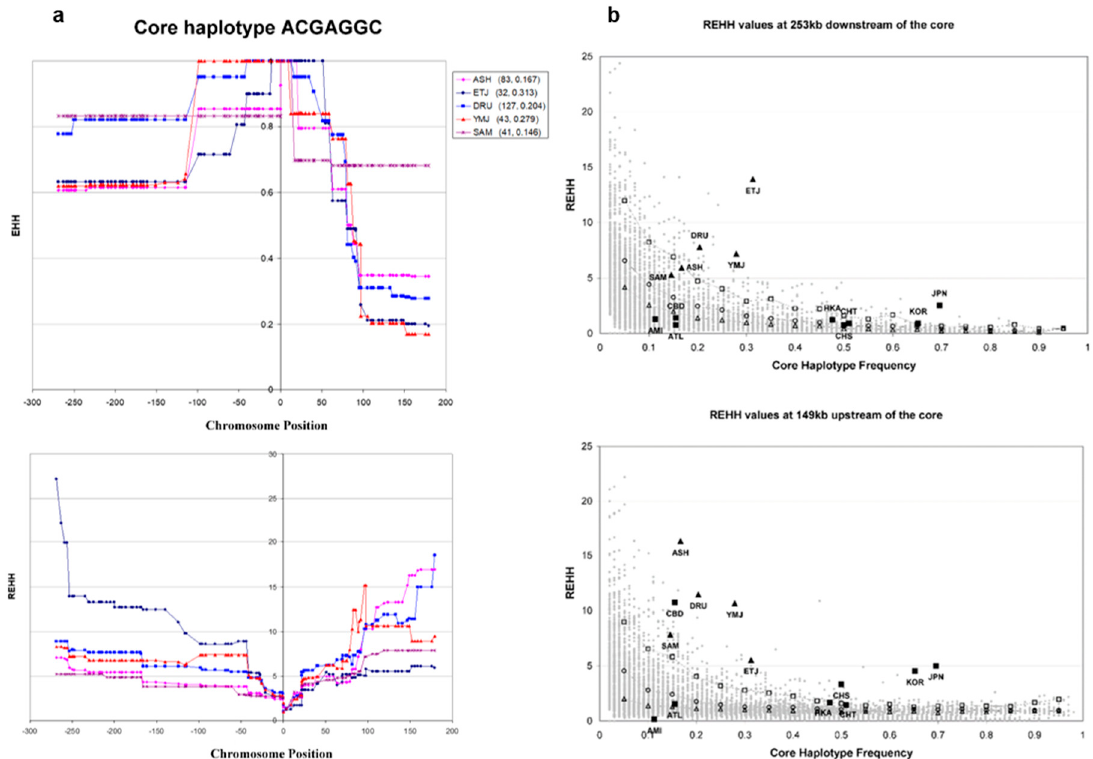
Figure 5. Extended haplotype homozygosity (EHH) and Relative EHH (REHH) plots in Southwest Asian and East Asian populations. The core haplotype position is defined to be zero. The left side of the core is toward downstream direction, while the right side of the core is toward upstream direction. ( a ) EHH and REHH results for the core haplotype TCGAGGC in Southwest Asian populations.